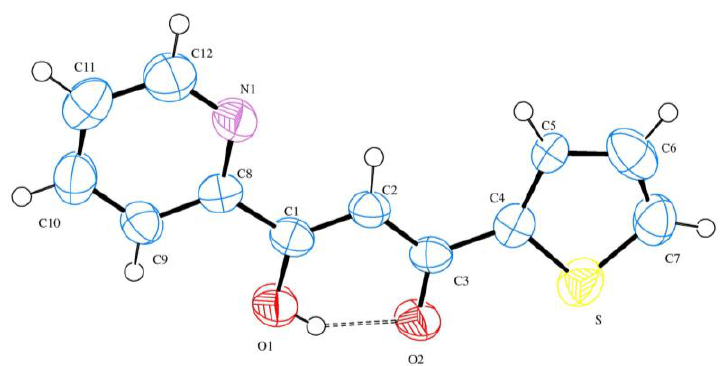
Figure 2. X-ray diffraction (XRD) of the target product.